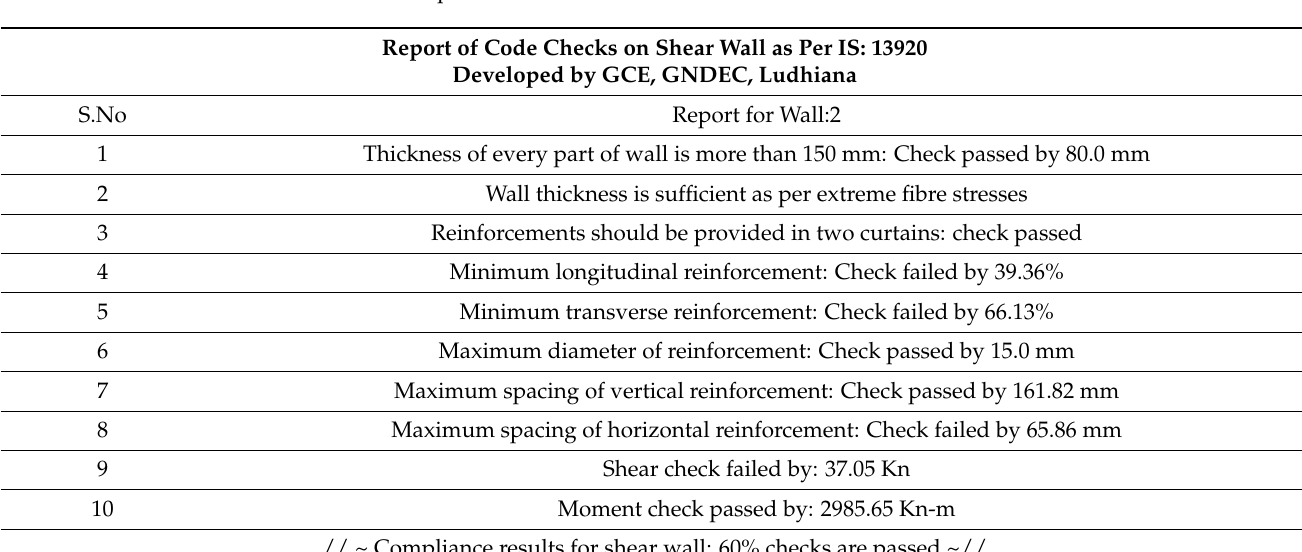
Table 7. Report File Generated for Shear Wall